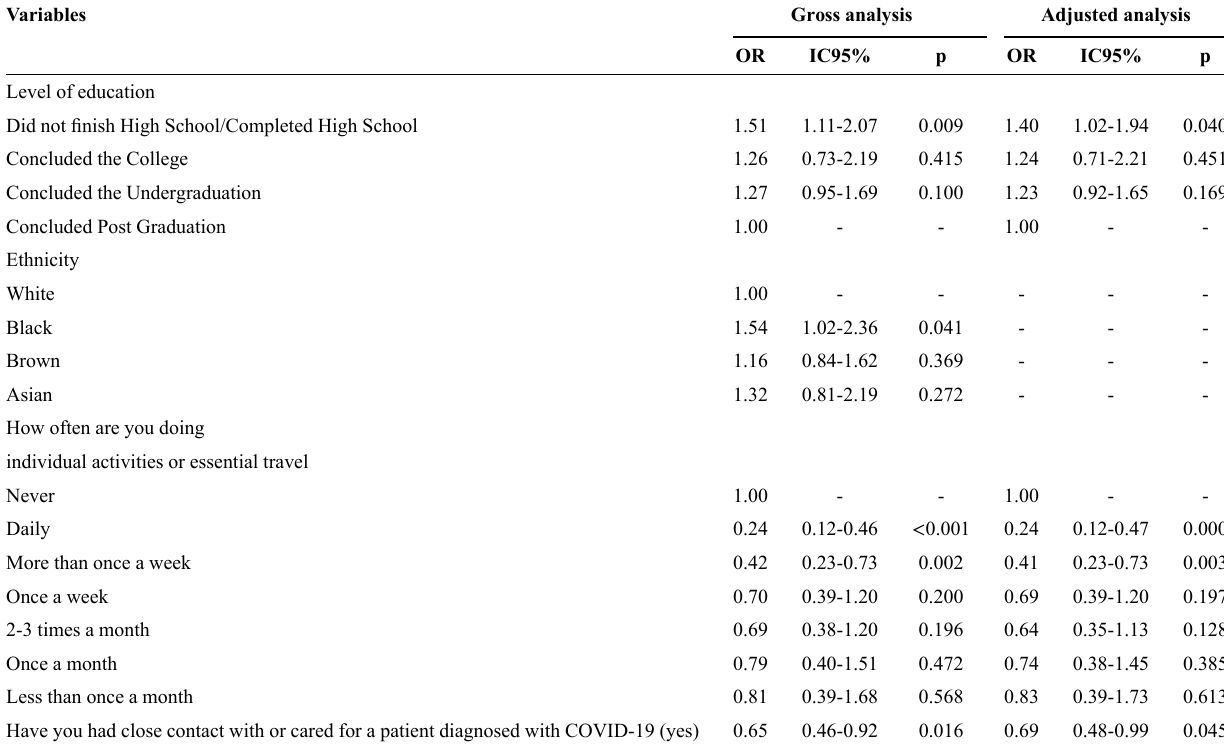
Table 2 - Factors associated with insufficient physical activity during social withdrawal (n = 1096) of residents of the city of Sao Paulo, SP, Brazil. Variables